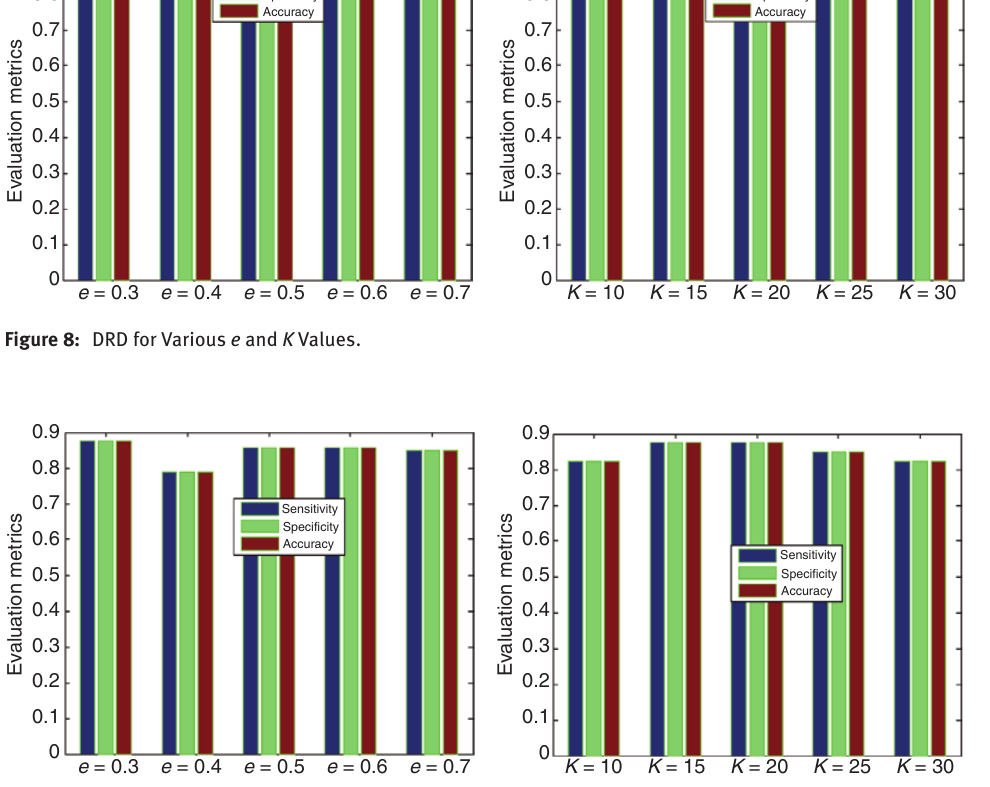
Figure 9: Lung Cancer Data for Various e and K Values.